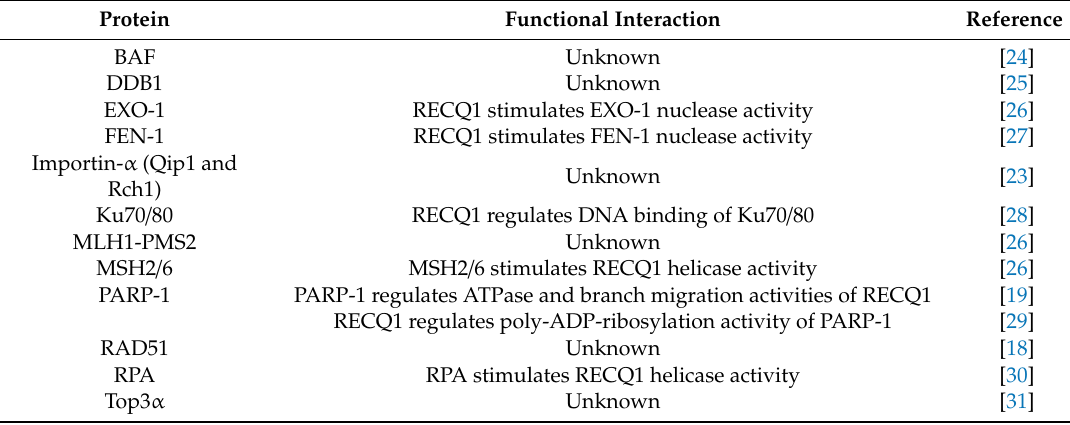
Table 1. Alphabetical list of the known interacting partners of